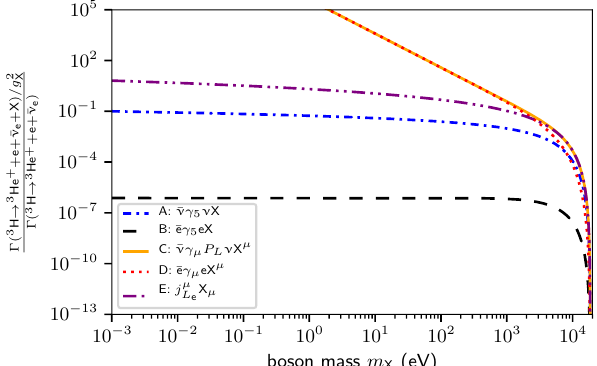
Figure 3 . Ratio of the decay width (cid:0)( 3 H ! 3 He + + e (cid:0) + (cid:22) (cid:23) e + X ) (divided by the relevant coupling constant g 2 ) with respect to the SM width as a function of the new boson’s mass m X . The different X curves are for different underlying coupling structures, see text for